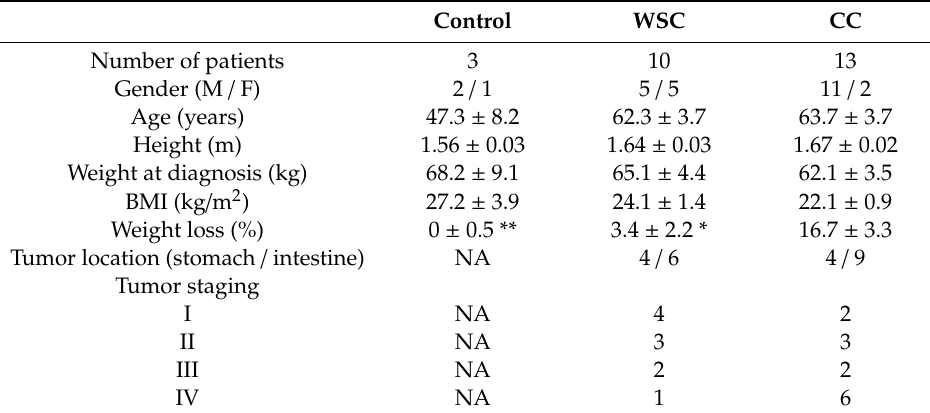
Table 1. Clinical features of patients included in this